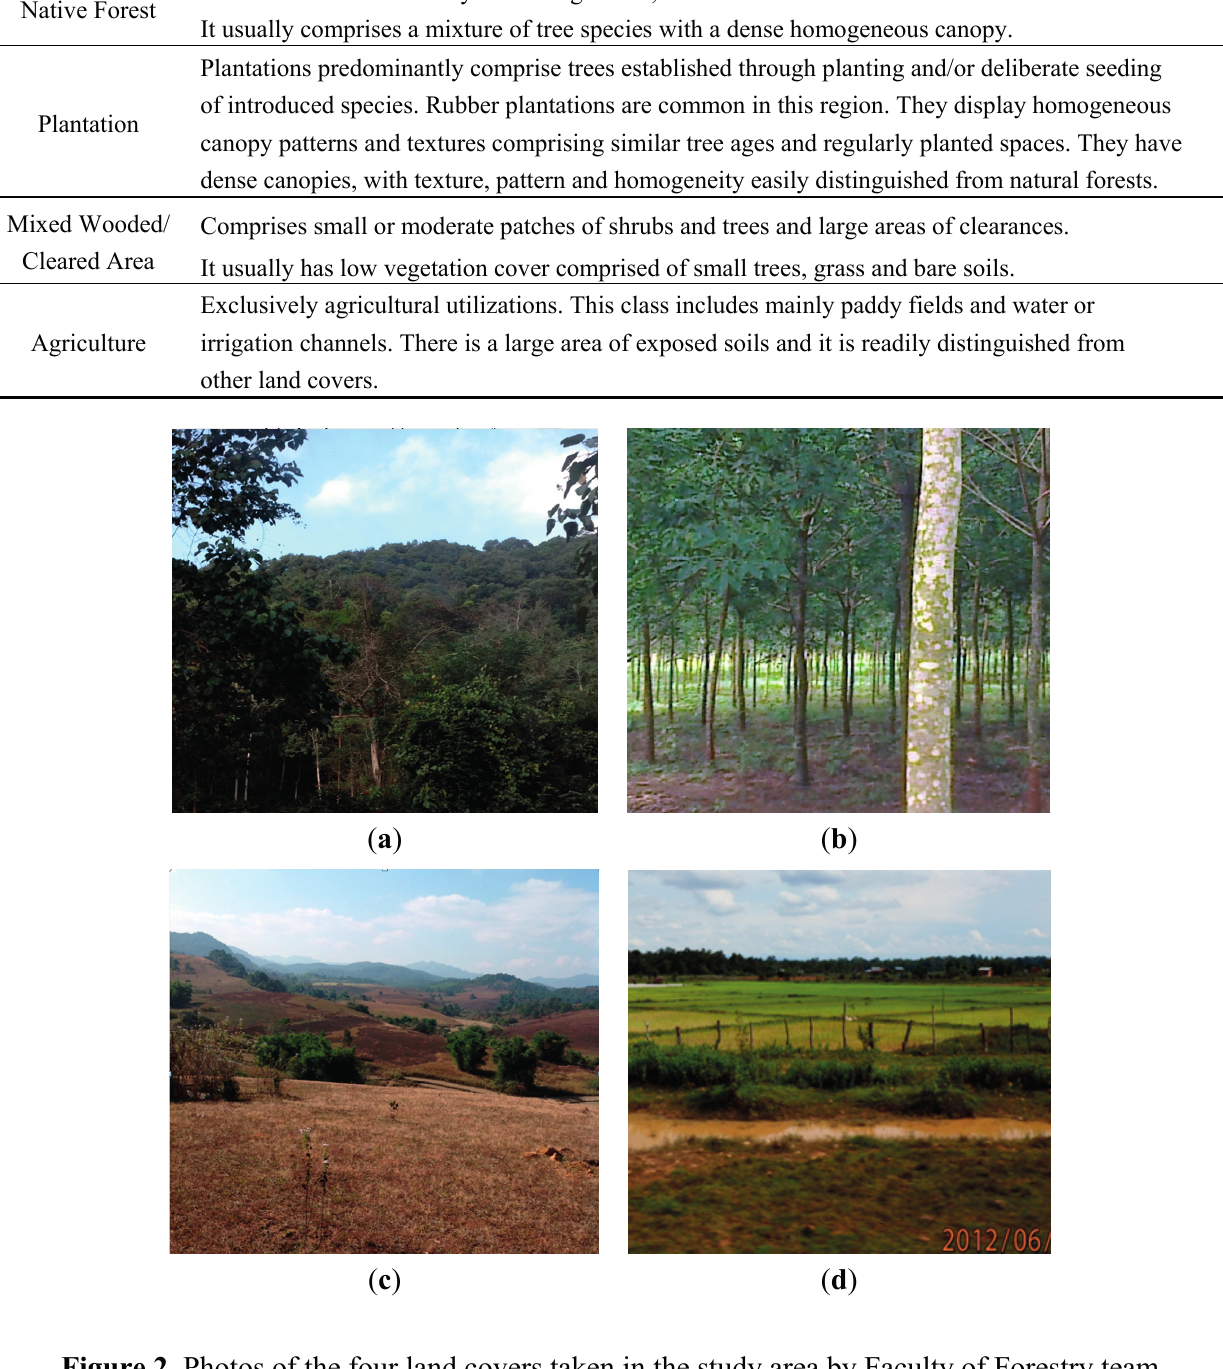
Figure 2. Photos of the four land covers taken in the study area by Faculty of Forestry team researchers, May–June 2012. (a ) native forest, ( b ) rubber plantation, ( c ) mixed wooded/cleared area, and ( d )